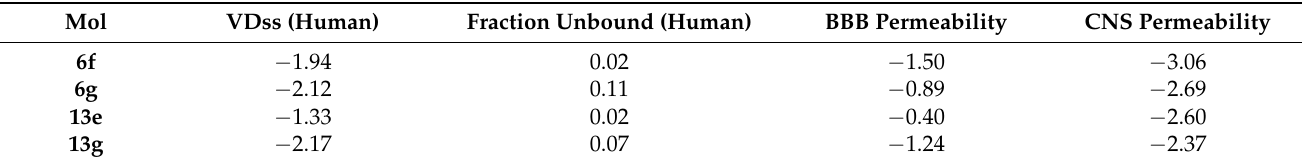
Table 5. pkCSM calculated distribution